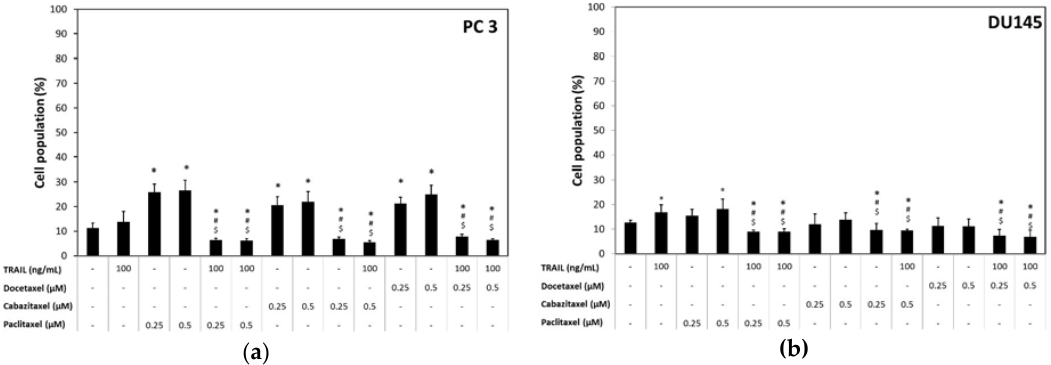
Figure 6. Effect of TRAIL (100 ng/mL) in combination with paclitaxel, cabazitaxel and docetaxel on CSCs number in DU145 and PC3 prostate cancer cells. * p < 0.05, significantly different from the respective control; # p < 0.05, significantly different from TRAIL alone; $ p < 0.05, significantly different from respective taxane alone. ( a ) CSCs number in PC3 prostate cancer cells after incubation with TRAIL (100 ng/mL) and/or paclitaxel, cabazitaxel, docetaxel; ( b ) CSCs number in DU145 prostate cancer cells after incubation with TRAIL (100 ng/mL) and/or paclitaxel, cabazitaxel, docetaxel.